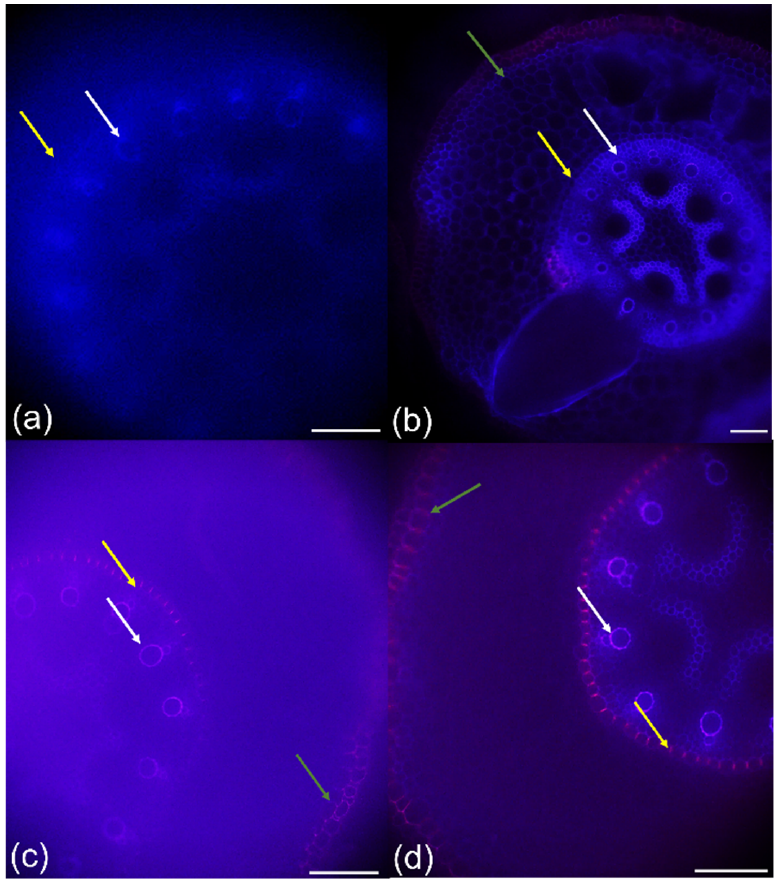
Figure 3. Lignification of the maize roots (hybrid Bielik) after 3 days of cultivation in the paper rolls as control ( a , c ) or treated with PAW ( b , d ). The hand cross sections were 10% from the root apex ( a , b ) or on the root base ( c , d ) and stained with phluoroglucinol-HCl. The arrows point at the exodermis (green), endodermis (yellow), and early metaxylem (white). Scale bars = 100 µm.